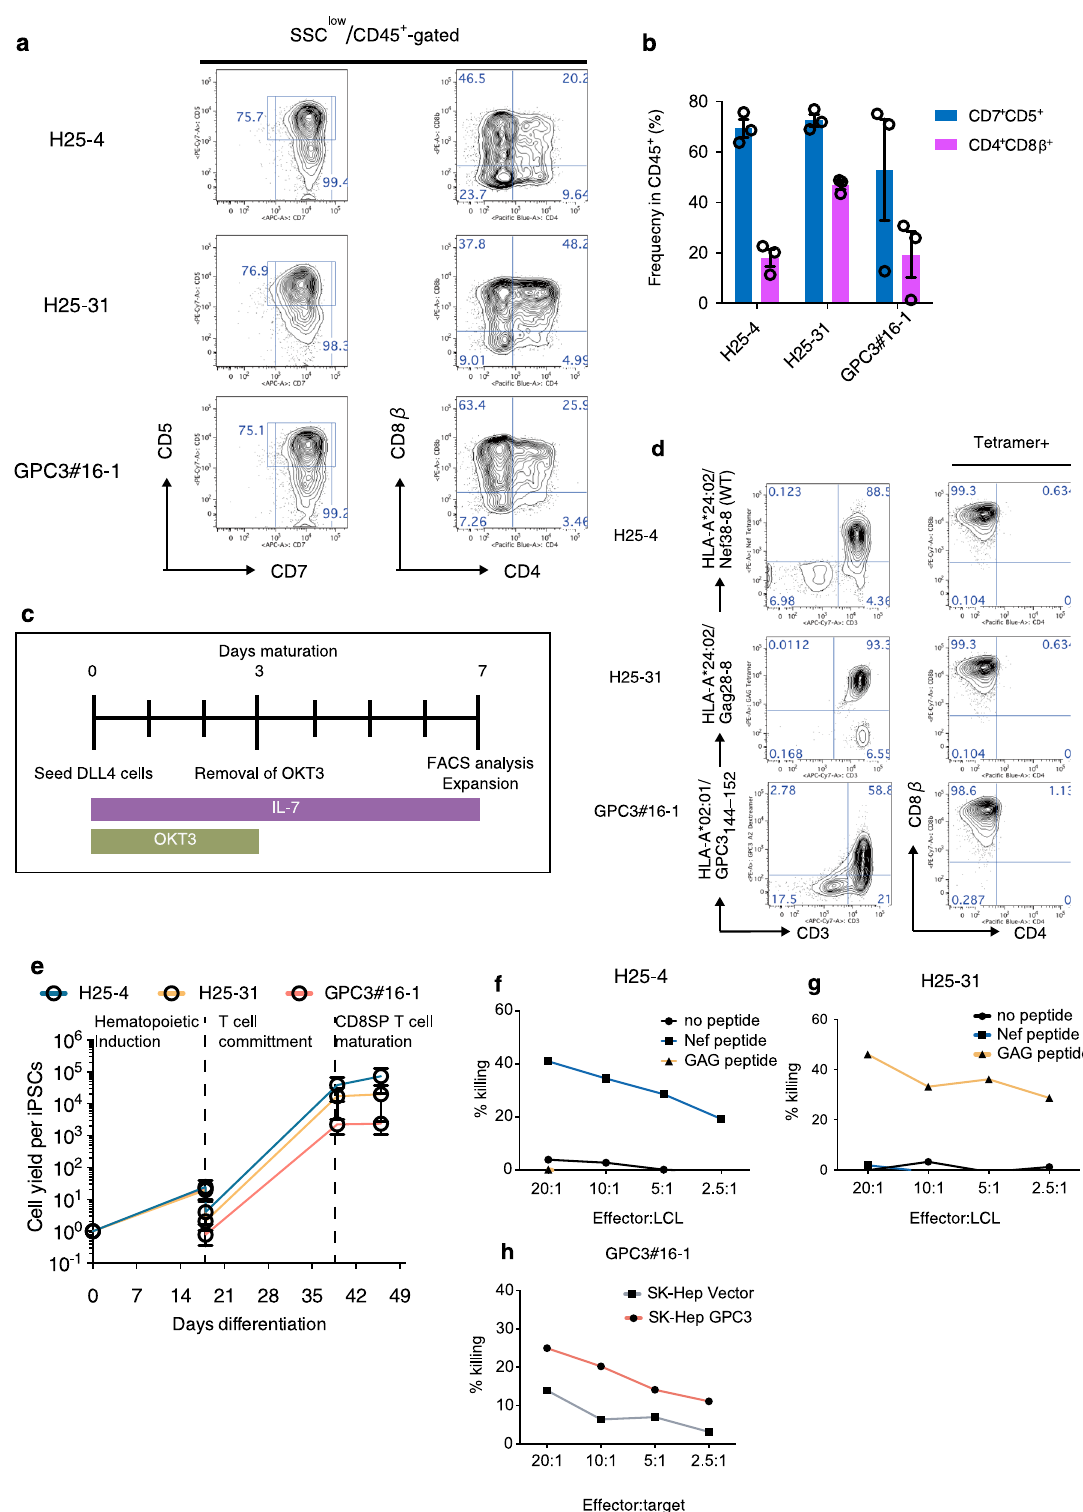
Fig. 4a. To mention brie fl y, HLA-homozygous iPSCs